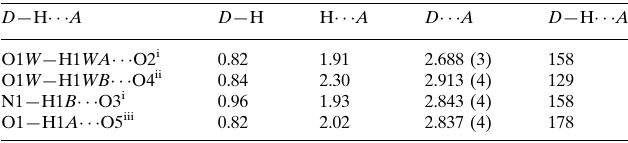
1355 Friedel pairs Flack parameter: 0.064 (16)